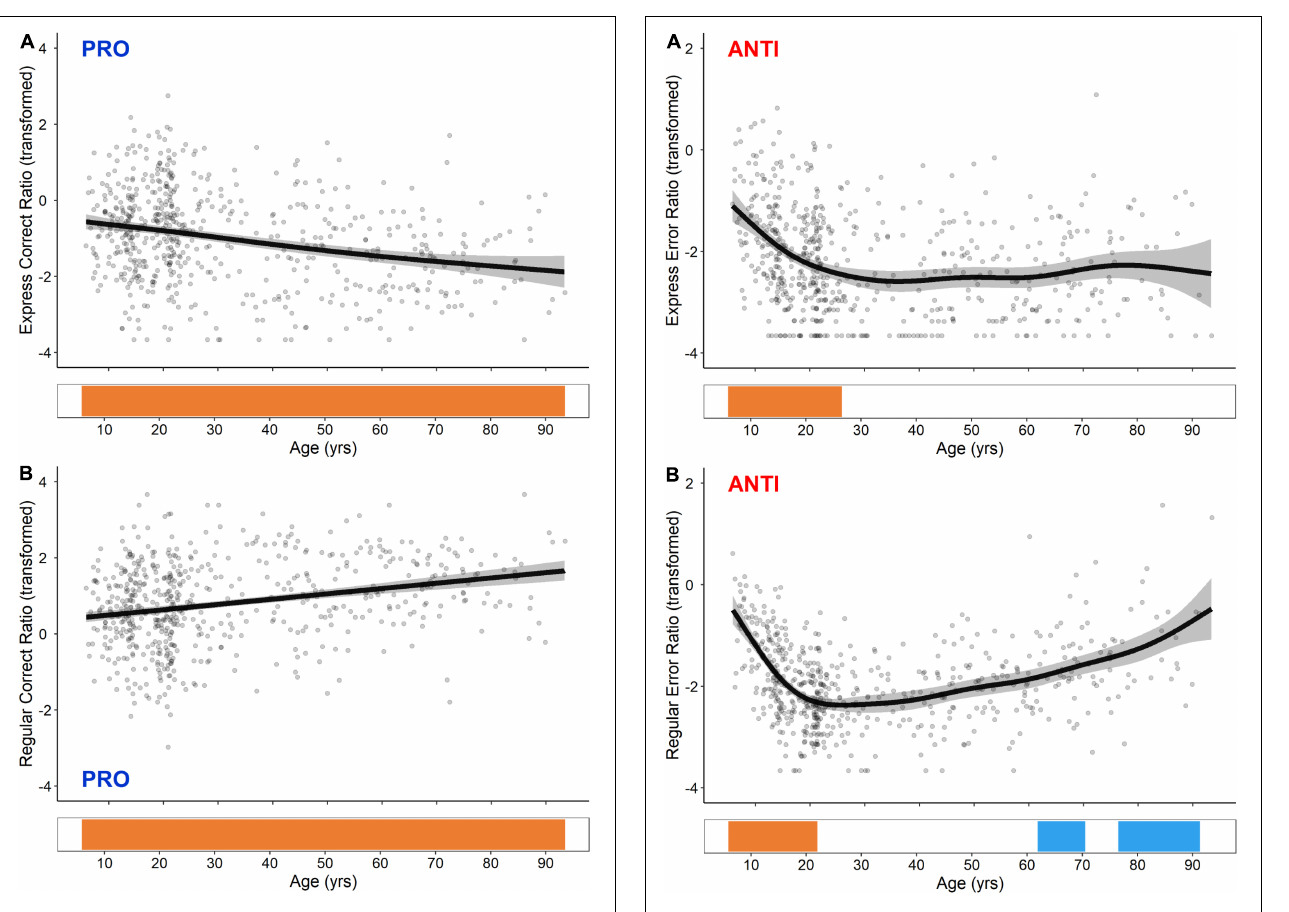
FIGURE 5 | GAM fits and significant periods of change for logit transformed ANTI express-latency (A) and regular-latency (B) direction error ratios. Scatter points are individual participants, black curves are the GAM fits, and gray ribbons are the 95% confidence intervals. Bottom tiles indicate significant periods of developmental-related (orange) and aging-related (blue)